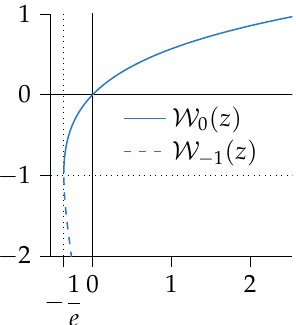
Figure 3. The two real branches of